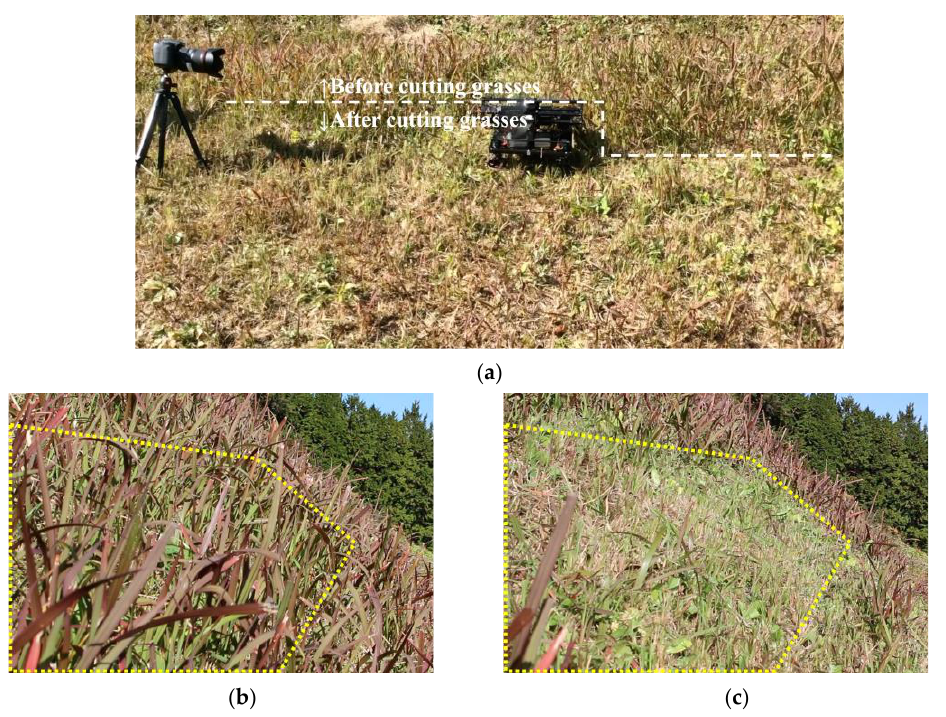
Figure 15. Grass cut by the robot on a slope with an inclination of 33 – 44°. ( a ) Experimental setting. ( b ) Before cutting the grass. ( c ) After cutting the grass.